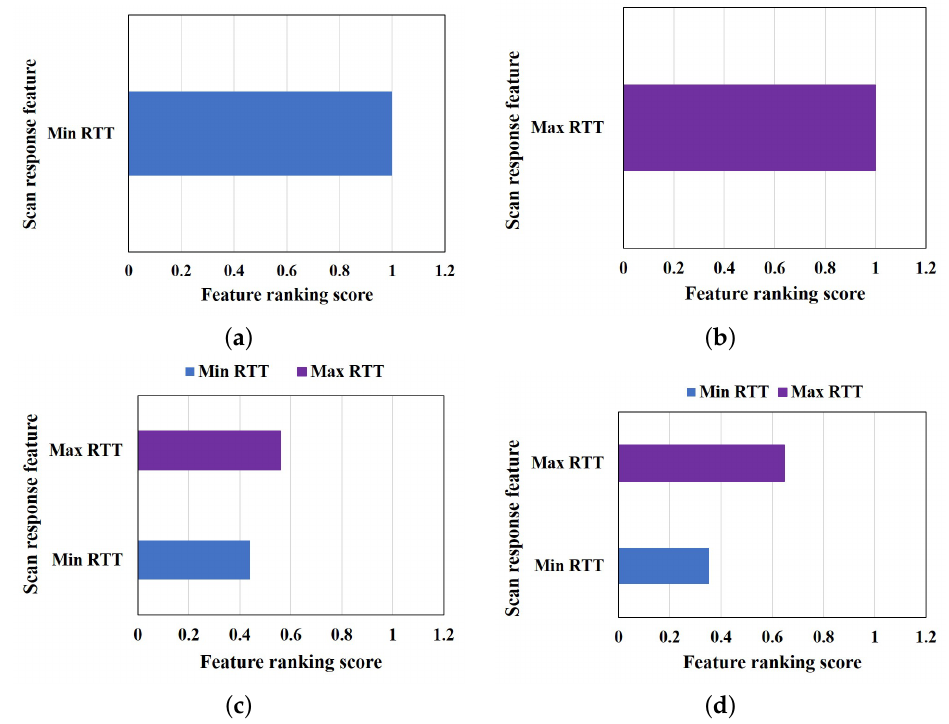
Figure 9. Feature selection using scan traffic: ( a ) Normal scenario; ( b ) low SNR scenario; ( c ) congestion scenario; ( d ) combined scan response—training